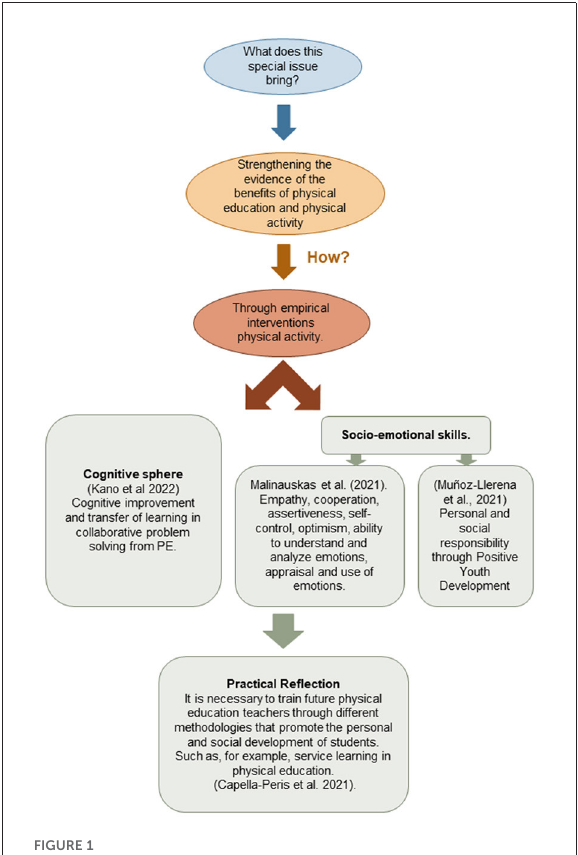
FIGURE1 Summary of special issue